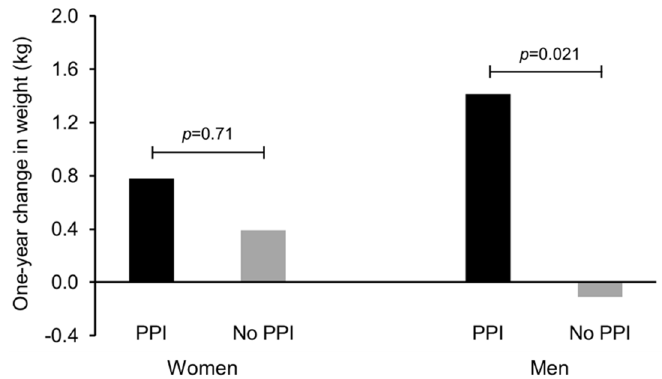
Figure 4. Change in measured body weight compared to self ‐ reported weight one year prior by proton pump inhibitor (PPI) use for men and women in the 2005–2006 NHANES. Adjusted for use of insulin, non ‐ insulin diabetic medications, use of lipid ‐ lowering medications, antidepressant use, number of non ‐ psychiatric/non ‐ diabetic drugs, BMI category, education, race/ethnicity, gender, and